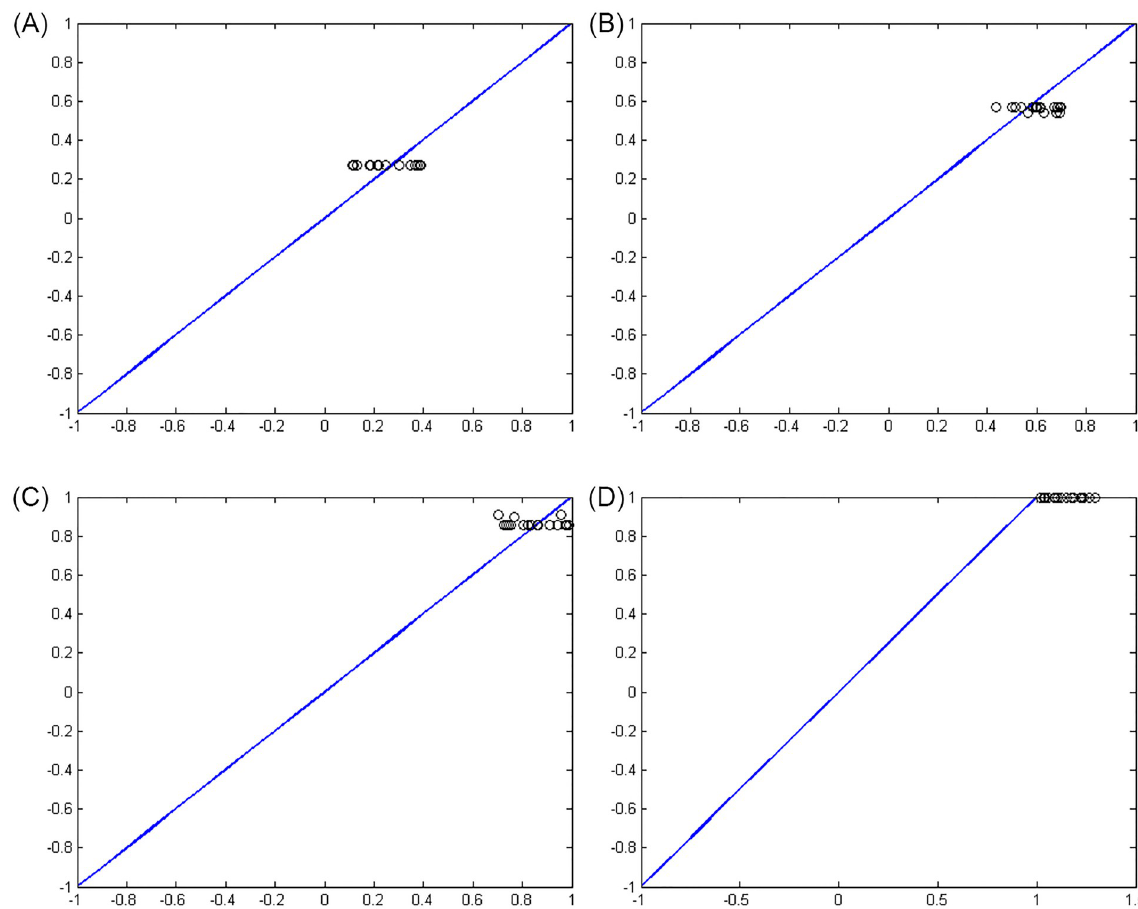
Fig 9. The distance between the real answers and the regression line (regression function) obtained with ANN-BTA in the test samples: (Fig 9A)[0.1, 0.4], (Fig 9B)[0.4, 0.7], (Fig 9C)[0.7, 1] and (Fig 9D)[1, 1.3] range.